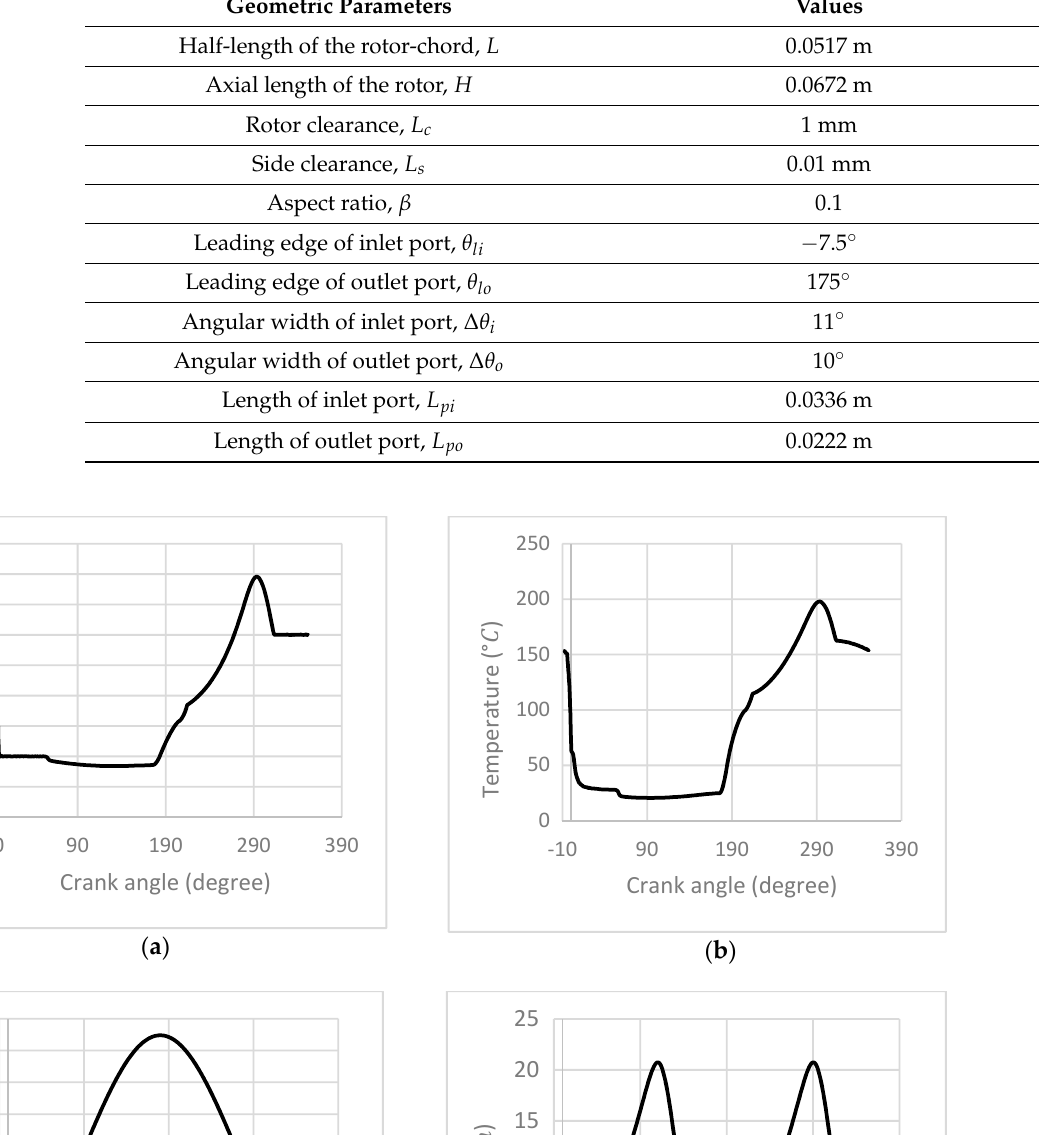
Table 1. Geometric parameters used in the simulation.